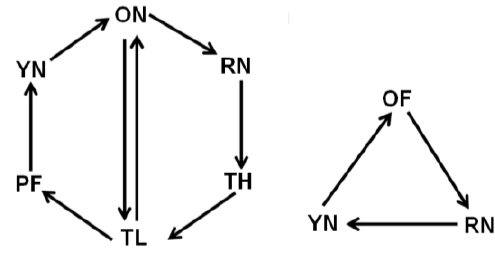
Figure 1. Microarray experimental design. The microarray experiment was designed with (cid:20)(cid:22)(cid:21)(cid:3) (cid:68)(cid:85)(cid:85)(cid:68)(cid:92)(cid:86)(cid:3) (cid:76)(cid:81)(cid:3) (cid:68)(cid:3) (cid:179)(cid:85)(cid:82)(cid:88)(cid:81)(cid:71) - (cid:85)(cid:82)(cid:69)(cid:76)(cid:81)(cid:180)(cid:3) (cid:86)(cid:87)(cid:92)(cid:79)(cid:72)(cid:17)(cid:3) (cid:40) ach arrow represents 6 arrays. YN = young